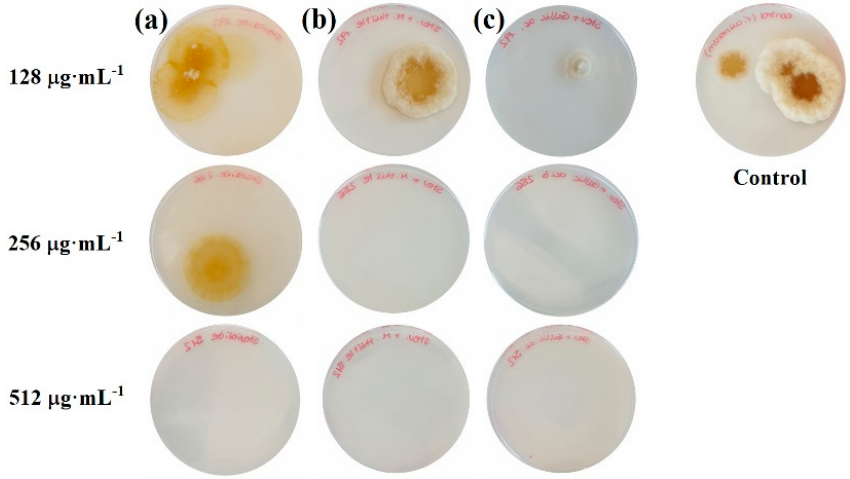
Figure 3. F. culmorum colonies formed after 5 days for the ( a ) stevioside, ( b ) stevioside–milk thistle seed extract, and ( c ) stevioside–gallic acid treatments. Only one replicate per treatment and concentration is shown.